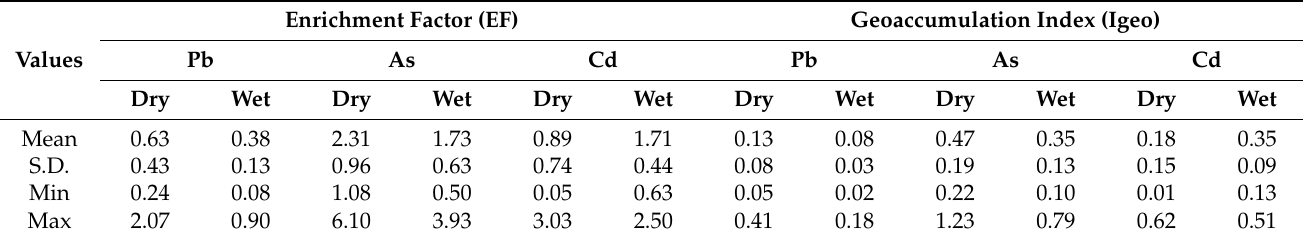
Table 4. The Enrichment factor (EF) and geoaccumulation index (Igeo) of sediment cores.